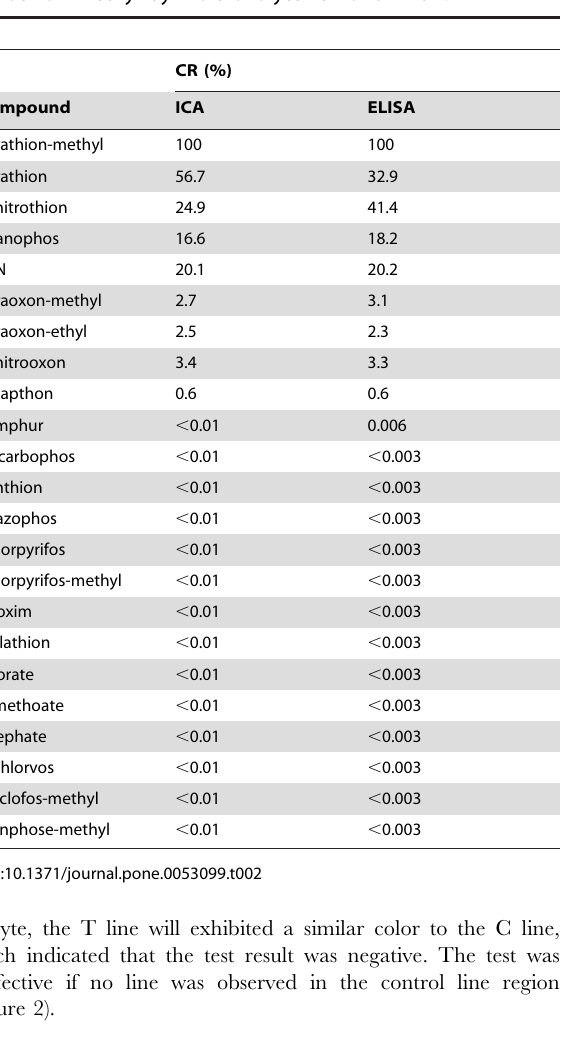
Table 2. Cross-reactivity (CR) of a set of analogs related to parathion-methyl by multi-analyte ICA and ELISA.